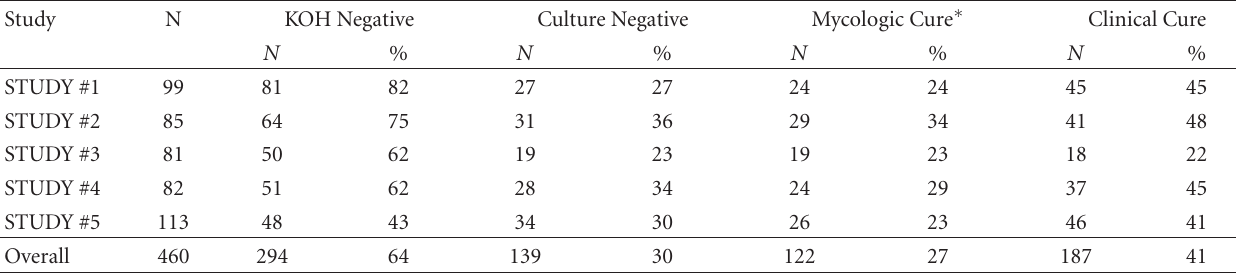
Table 4: Cure rates at six weeks by